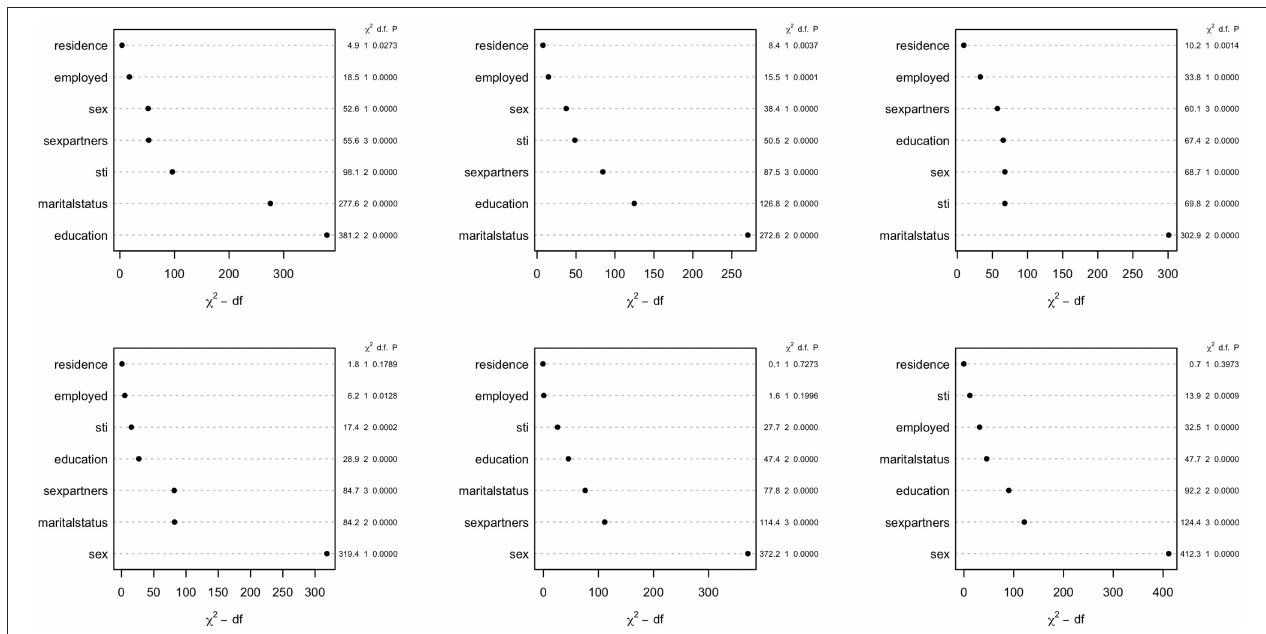
FIGURE 5 | Dot chart showing relative importance of covariates for the Zimbabwe DHS 2005–06 (left column), 2010–11 (middle column), and 2015 (right column). Model 1 (top row) and Model 2 (bottom row).